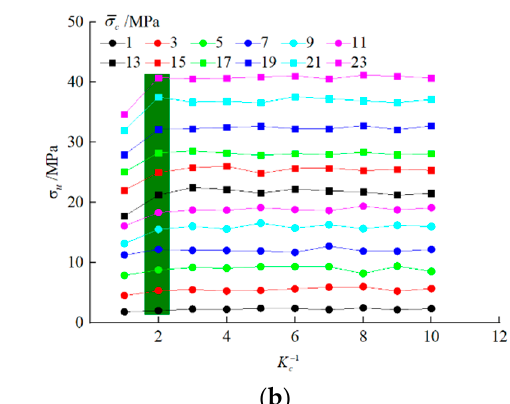
Figure 5. Effects of tensile-shear bond strength ratio on the difference in quantity between tensile and shear cracks.